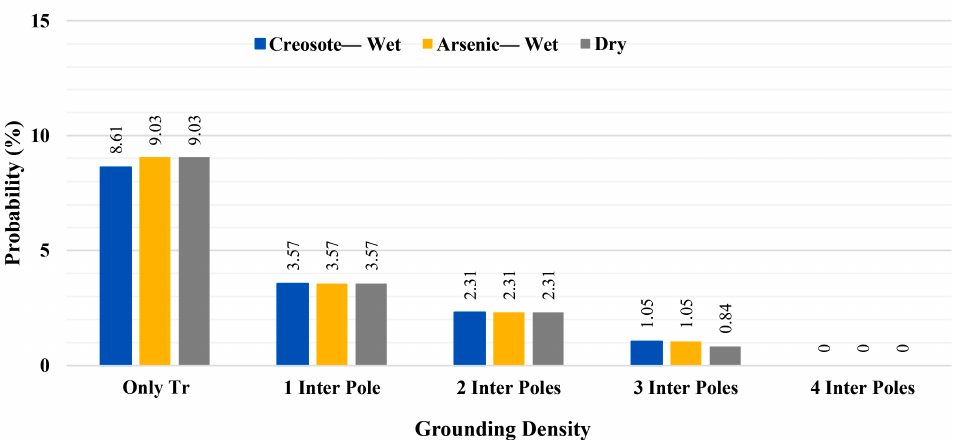
Figure 17. Comparison among the probabilities of transformers overvoltage stress above 85 kV under different grounding conditions, Case